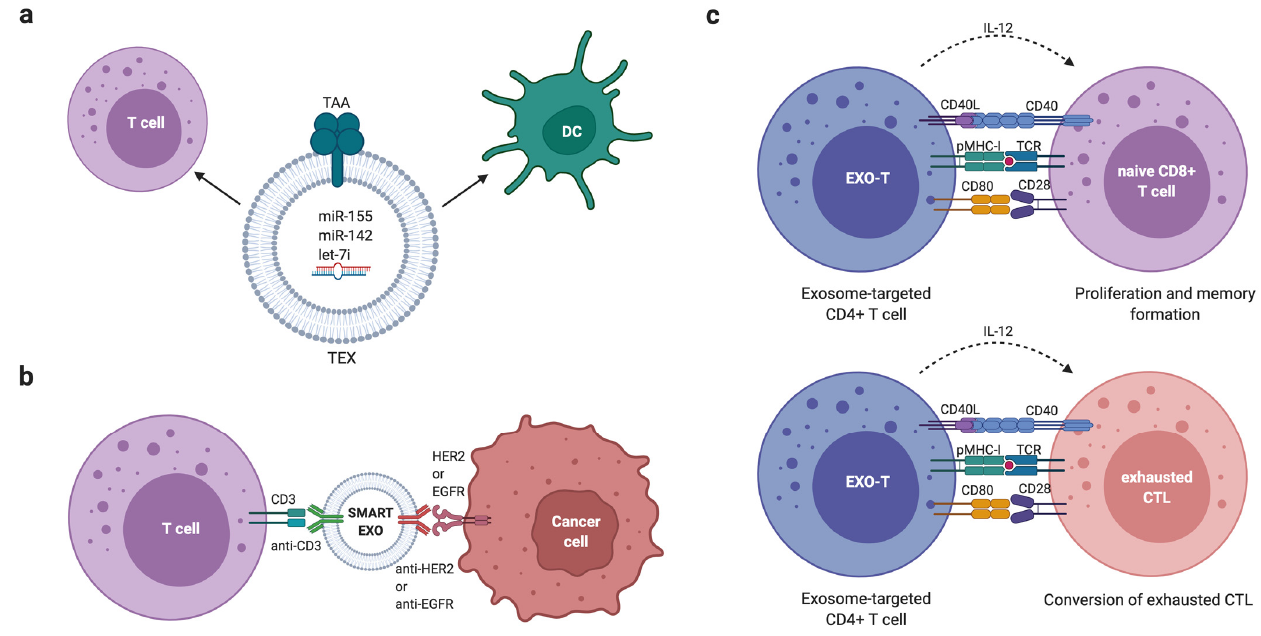
Figure 5. Extracellular Vesicle-Based Cancer Immunotherapies. ( a ) Tumour-derived EVs carrying tumour-specific and tumour-associated antigens (TAAs) and modified breast tumour-derived exosomes (TEX) with miR-155, miR-142, and let-7i, may be reasonably used as sources to stimulate T cells and dendritic cells (DCs) against cancer cells. ( b ) EVs have been genetically engineered for displaying specific monoclonal antibodies on their surface, such as anti-CD3 and anti-HER2 (human epidermal growth factor receptor 2) or anti-EGFR (epidermal growth factor receptor) resulting in novel synthetic multivalent antibodies retargeted exosomes (SMART-EXO) that can simultaneously target immune and cancer cells. ( c ) A novel HER2-specific exosome-T vaccine using polyclonal CD4+ T cells armed with exosomes derived from HER2-specific DCs (EXO-T) has been developed. Distinct three signals derived from novel EXO-T vaccine include (1) exosomal pMHC-I/TCR, (2) exosomal CD80/CD28 and T cell CD40L/CD40 (for T-cell memory formation), and (3) T-cell cytokine IL-2 (for T-cell proliferation). Conversion of exhausted CD8+ CTLs (cytotoxic T lymphocytes) within tumours by EXO-T cells via a T cell CD40L/CD40-activated mTORC1 pathway can also occur.